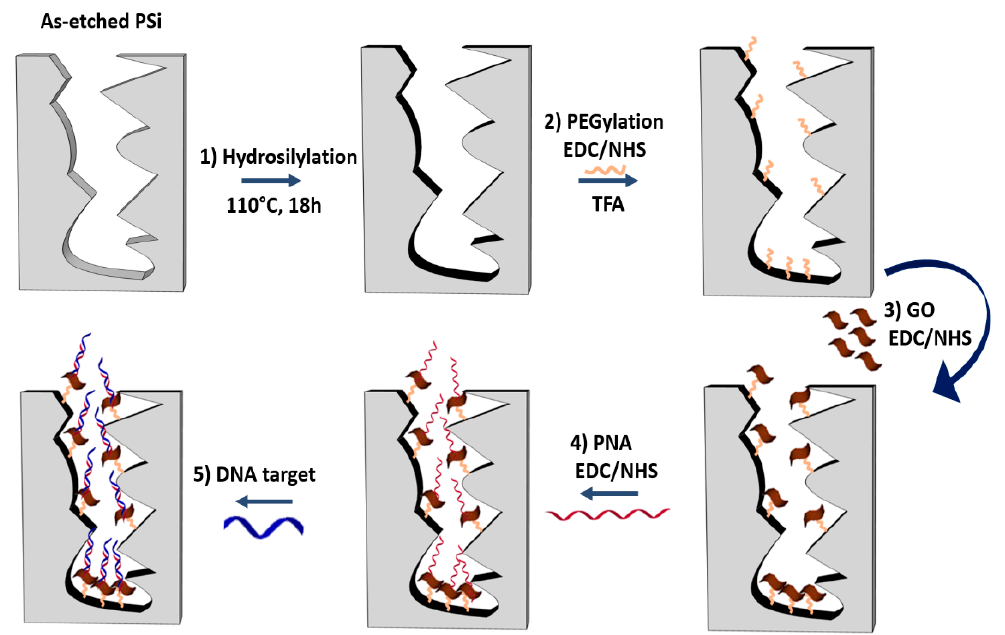
Figure 1. Functionalization scheme of GO / PSi hybrid device with the PNA probe and hybridization with the DNA target. Reaction 1: hydrosilylation of PSi by UDA (18 h at 110 ◦ C). Reaction 2: PEGylation of PSi by EDC / NHS chemistry and deprotection of NH-BOC group by TFA treatment. Reaction 3: GO conjugation to PEGylated-PSi by EDC / NHS. Reaction 4: immobilization of the PNA by a covalent chemistry. Reaction 5: DNA target recognition by